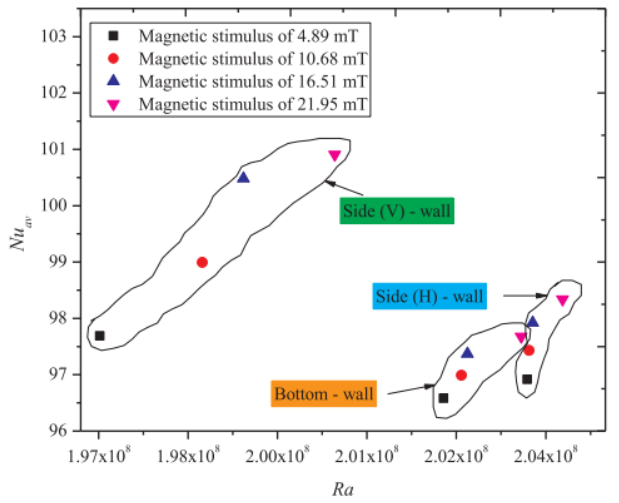
Figure 22. Nu av enhancement with increasing magnetic induction. Reprinted with permission from Ref. [43]. 2020, Elsevier.